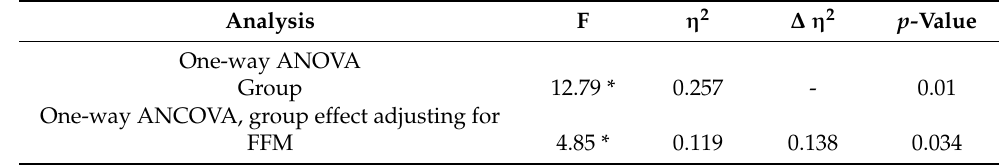
Table 6. Effect of covariates on group differences in ad libitum energy intake. Analysis